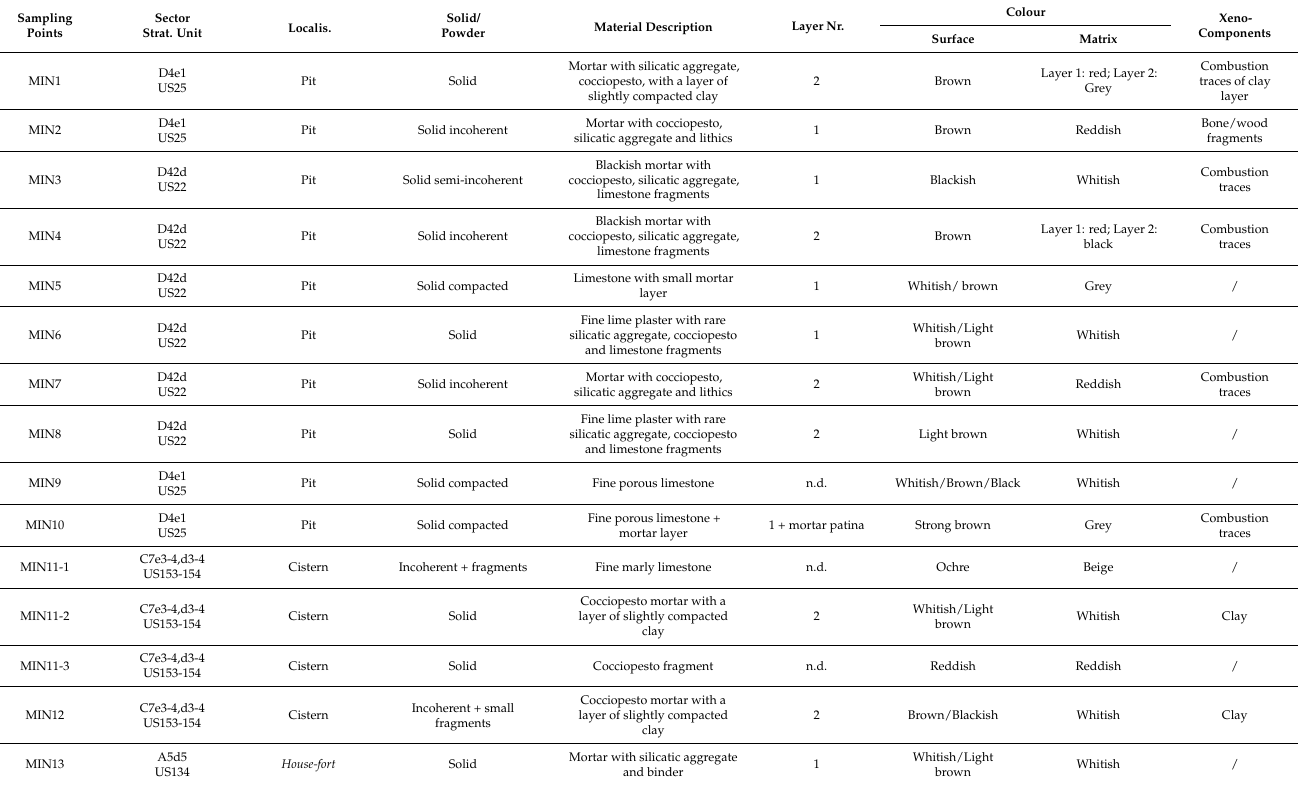
Table 1. Macroscopic description of samples taken from the archaeological site of Cap de Forma.